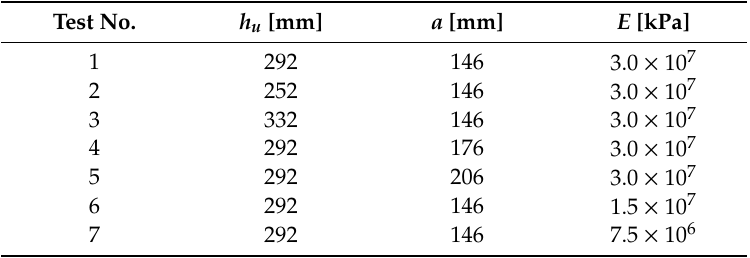
structure, the other available data used for comparison is from the published literature [5-7]